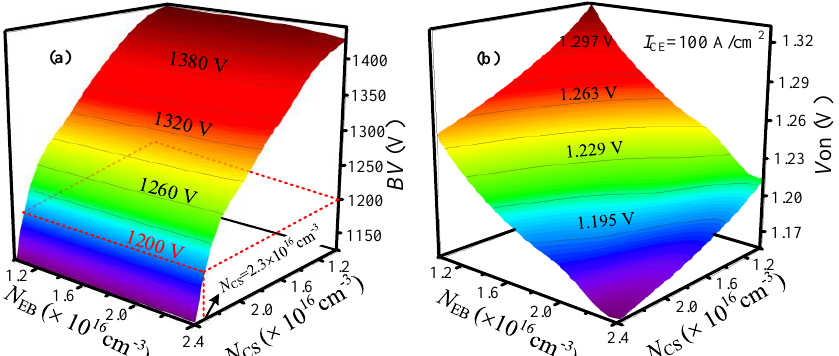
Figure 7. BV and V on dependence on doping concentration in SJ-RC-IGBT. ( a ) Effect of N CS and N EB on BV. ( b ) Effect of N CS and N EB on V on .